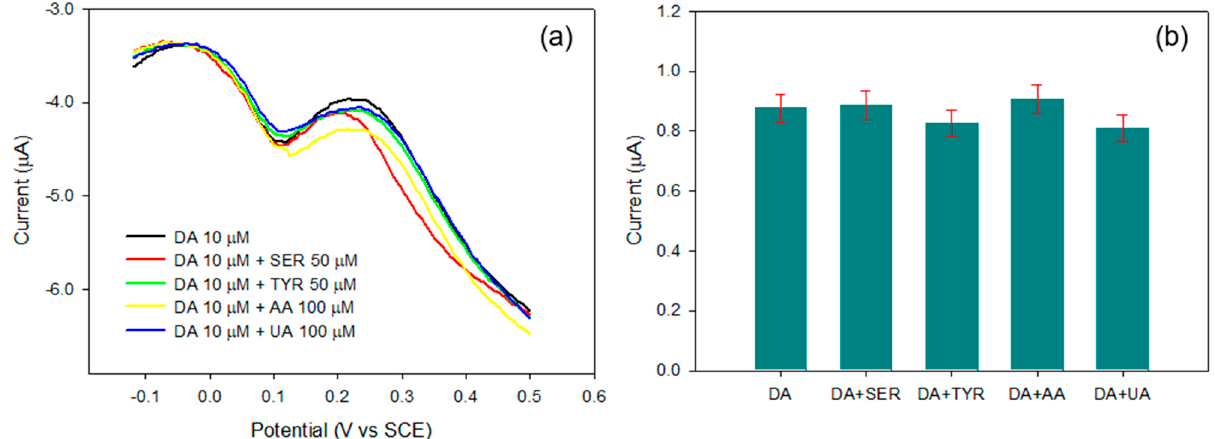
Figure 7. ( a ) DPVs of 10 µ M dopamine in the absence and in the presence of serotonin 50 µ M, tyramine 50 µ M, ascorbic acid 100 µ M, and uric acid 100 µ M at the MIP-modified electrode. Electrolyte: phosphate buffer solution, pH 7.0 and I = 0.1 M. Potential increment: 4 mV; sampling width: 20 ms; pulse amplitude: 50 mV; pulse period: 0.2 s; pulse width: 50 ms. ( b ) Mean values and error bars relevant to replicate experiments (n = 3).